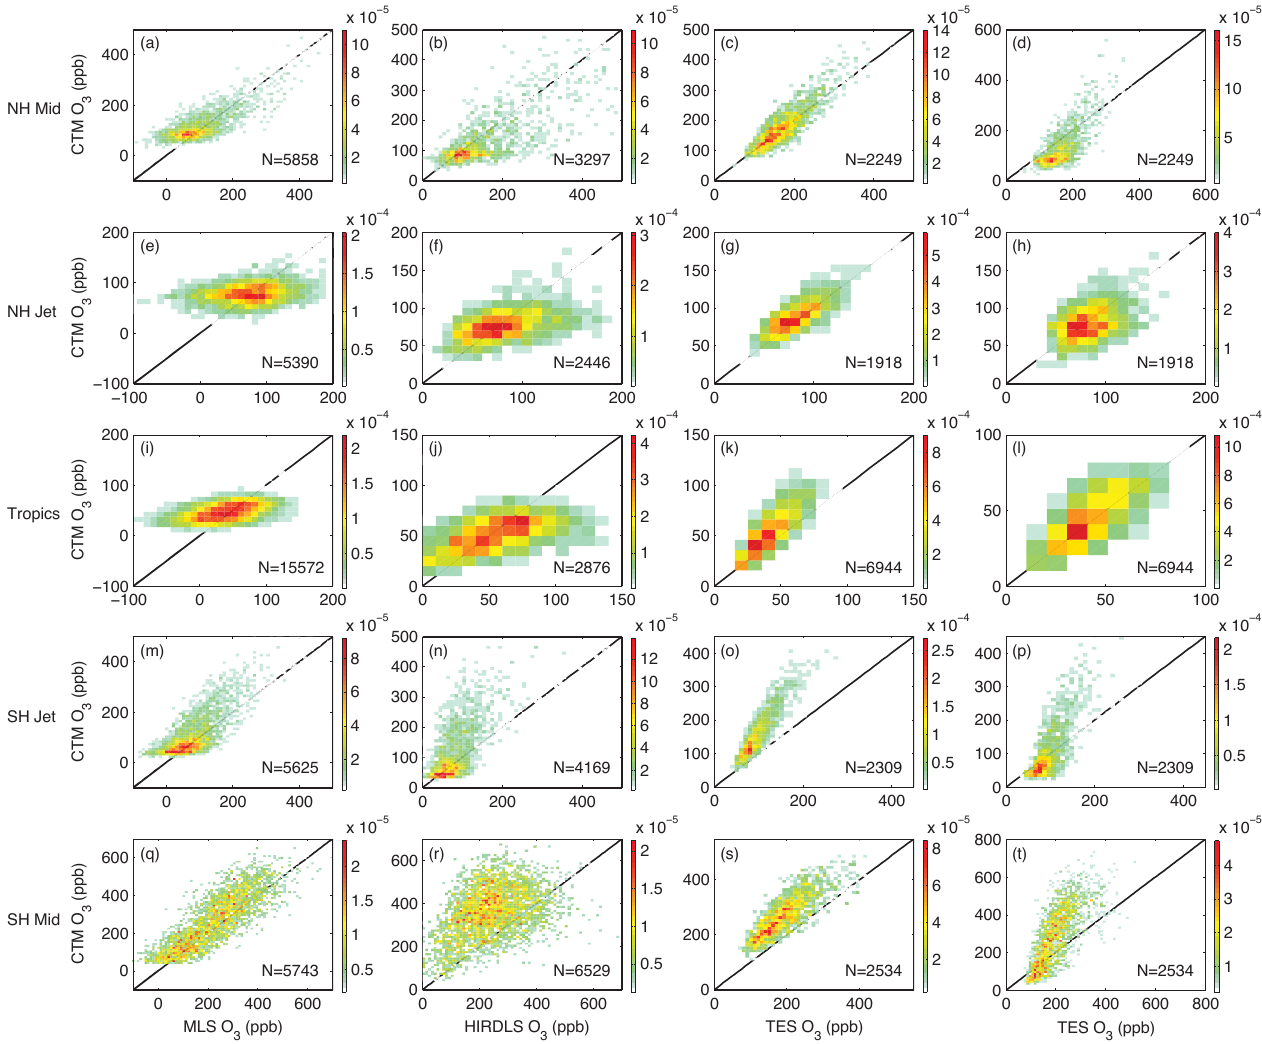
Fig. 5. 2-D probability density functions (PDFs, unit: ppb − 2 ) of CTM vs. Aura O 3 for July 2005 at 215hPa. Rows from top to bottom are for NH middle latitudes (40 ◦ N–50 ◦ N), NH jet (25 ◦ N–35 ◦ N), tropics (15 ◦ S–15 ◦ N), SH jet (35 ◦ S–25 ◦ S), and SH middle latitudes (50 ◦ S–40 ◦ S). Comparisons for different Aura ozone datasets are presented in columns from left to right: MLS, HIRDLS, and TES. The CTM results processed with the TES operator are shown in the third column, and the raw model results in the fourth column. The 2-D PDF includes all the good CTM-Aura pairs in the month and is weighted by the inverse of observation times for each latitude. It is normalized to give a 2-D integral of 1. N is the number of comparisons and the solid black line shows the 1:1 line. The mean biases and RMS are given